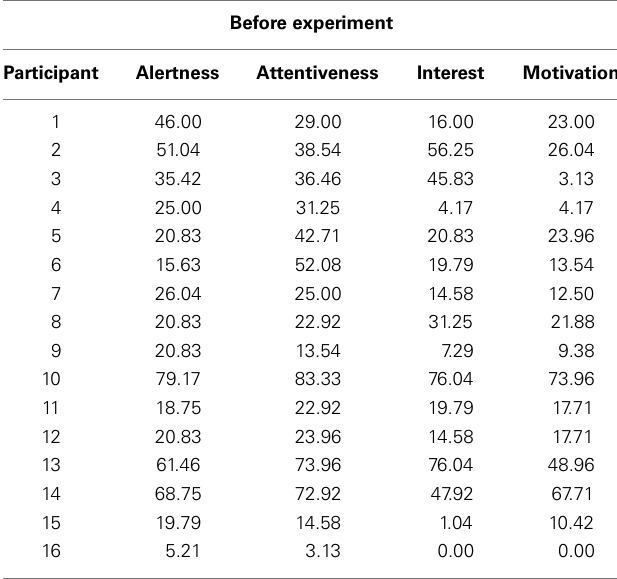
FIGURE 4 | Mean RTs as a function of congruency and block in Experiment 2. Congruent (white bars) and incongruent condition (gray bars) for target present displays in the first block (left) and second block (right). Error bars indicate the standard errors of the mean, adapted to within-participants designs, according to procedure described in Cousineau